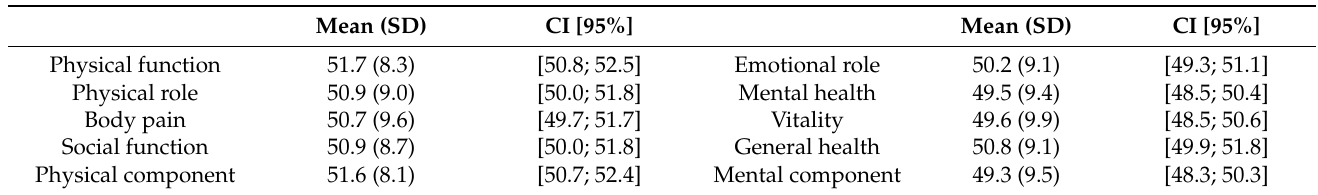
Table 1. Catalonian population norms of the SF-12 dimensions for women aged 44–53 years in 2012. Mean (SD) CI